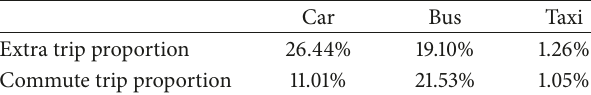
Table 2: Distribution of extra and commute trips. Table 3: Coefficient of travel cost of all types of travel mode.